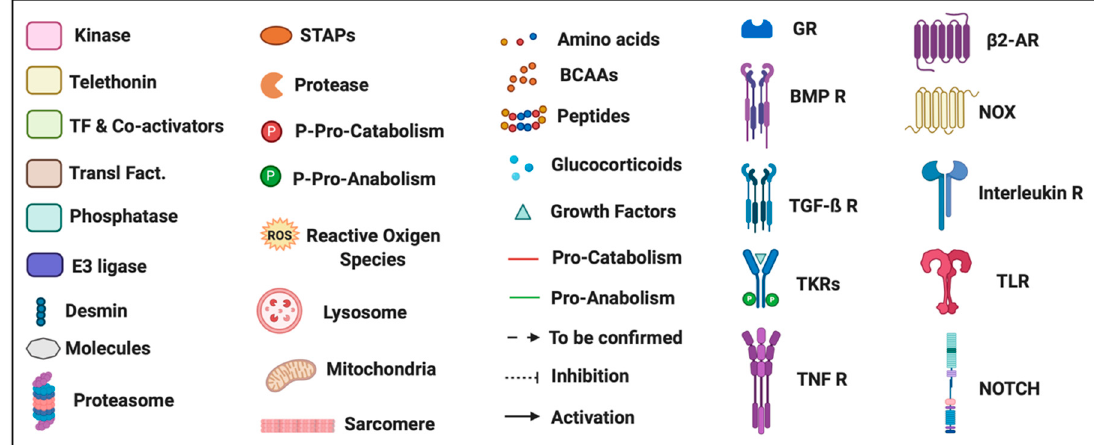
Figure 2. E3 ubiquitin ligases regulating skeletal muscle mass and molecules developed to modulate their activity and expression. Myofiber representation of the different E3-ligases and molecules targeting the signaling pathways controlling skeletal muscle mass and function during atrophy conditions. Ligands and arrows (both with head or perpendicular line) in green denote those signaling pathways and interactions with an anabolic effect whereas the red ones indicate catabolic signaling. ß2-AR: ß-2 Adrenergic Receptor; BCAAs: Branched-chain amino acids; BMP R: Bone Morphogenetic Receptor; Calp: Calpain; CSL: CBF1, Suppressor of Hairless, Lag-1; GR: Glucocorticoid Receptor; IL-6: Interleukin-6; NCID: Notch Intracellular domain; NOX: NADPH oxidase activator; P: Phosphorylation; STAPs: Signal Transducing Adaptor Proteins; TF: Transcription Factors; TGF-ß R: Transforming Growth Factor ß Receptor; TKR: Tyrosine-protein Kinase Receptor; TLR: Toll-like Receptor; TNF R: Tumor Necrosis Factor Receptor; Transl. Fact.: Translational Factors.